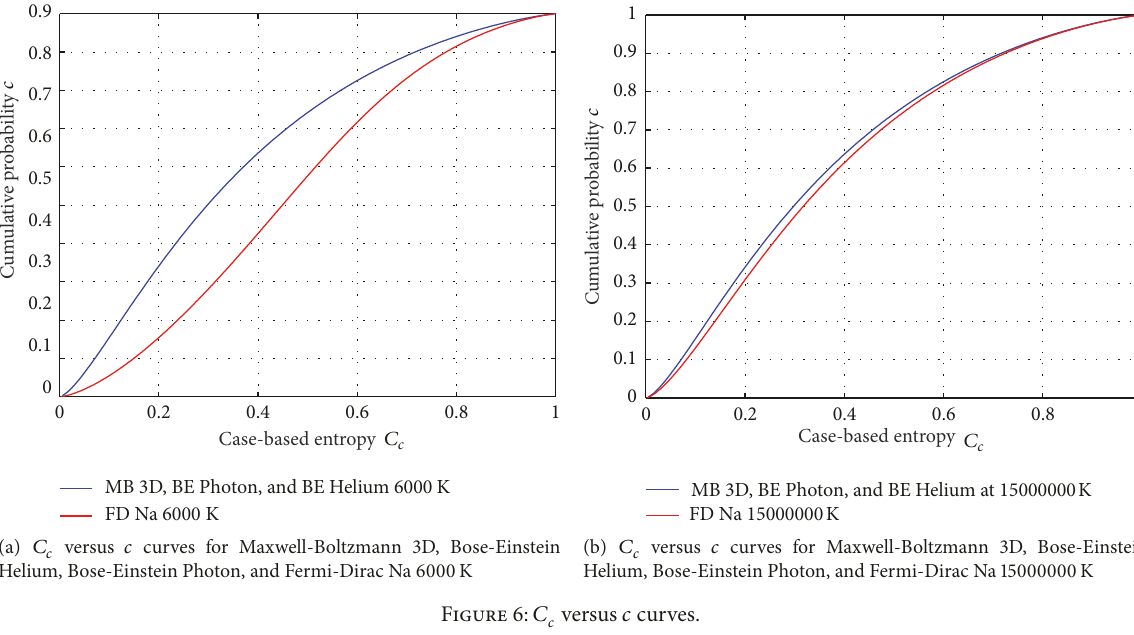
(b) 𝐶 𝑐 versus 𝑐 curves for Maxwell-Boltzmann 3D, Bose-Einstein Helium, Bose-Einstein Photon, and Fermi-Dirac Na 15000000K Figure 6: 𝐶 𝑐 versus 𝑐